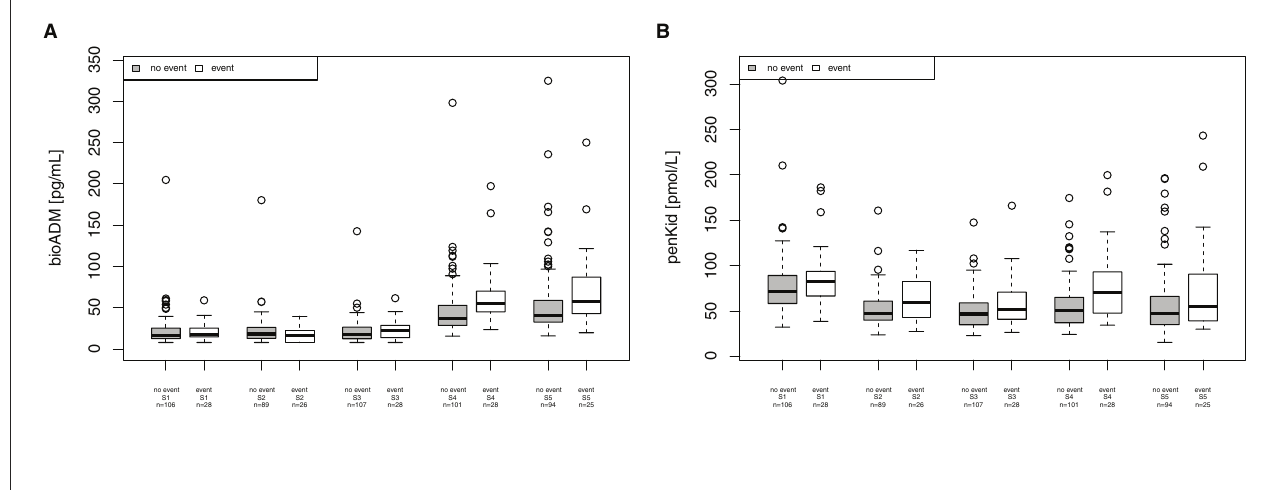
FIGURE4 Association of bioactive Adrenomedullin (bio-ADM) and proenkephalin A (penKid) with the combined endpoint “in-hospital mortality, patients receiving mechanical ventilation support, re-intubation, post-surgery infection and wound infections” (A) bio-ADM and (B) penKid; n, number of patients; S1, prior to surgery; S2, intraoperatively at the end of cardiopulmonary bypass; S3, at ICU admission; S4, 24h after surgery; and S5, 48h after